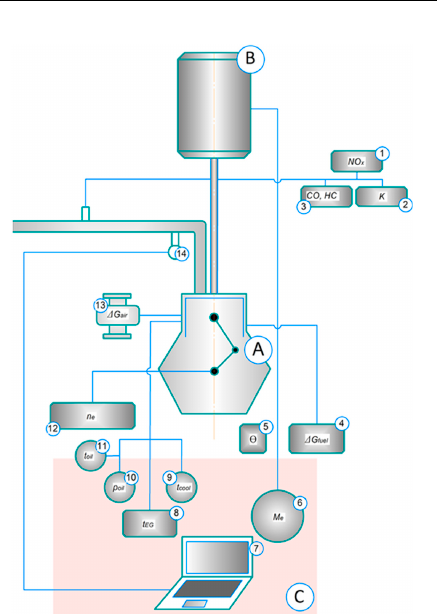
Figure 1. Diagram of the experimental installation: ( A )—D-241 diesel; ( B )—AKB 82-4 electric ma- chine; ( C )—control panel; 1—344HL-14 gas analyzer; 2—INA-109 opacimeter; 3—INFRAKAR gas